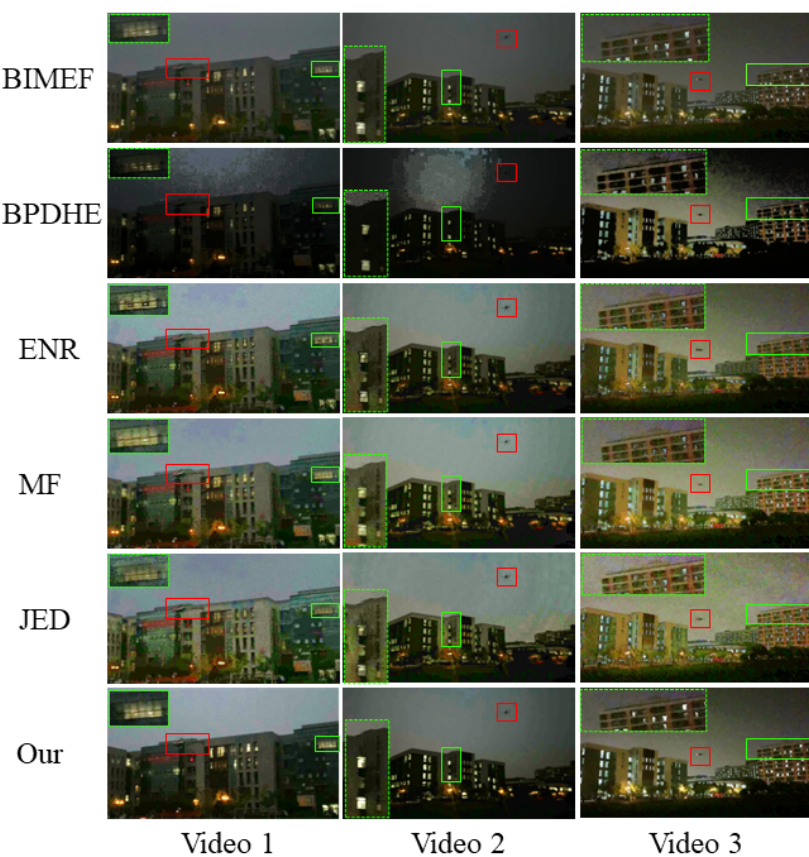
Figure 13. Enhancement results of different algorithms for Video 1 (containing the Align 700L V2 obstacle object), Video 2 (containing the DJI F450 obstacle object), and Video 3 (containing the DJI Mavic 2 Pro obstacle